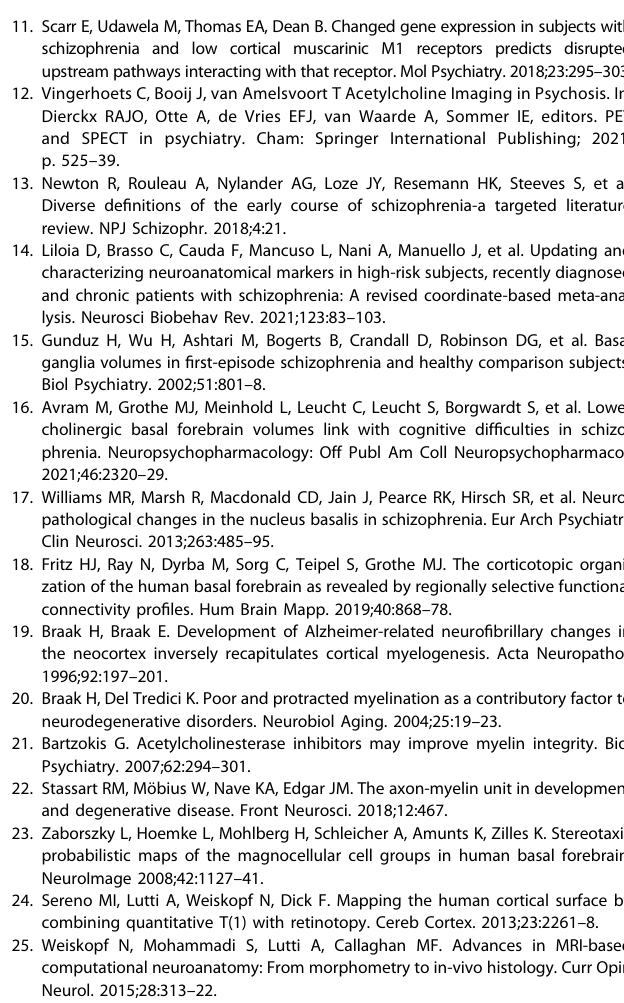
Fig. 6 Summary of neuroimaging, clinical, and transcriptomics analyses. (1) Clinical sample neuroimaging results examining case-control differences in microstructure, structure-MRS relationships, and clinical correlates of microstructure. We found increased qT1 and AxD in FEP compared to healthy controls (HC). In HC, there was a signi fi cant correlation between qT1 (left NBM) and MRS choline, while left NBM was related to negative (AxD) and manic symptom (qT1) burden. (2) Validation of basal forebrain microstructure measures using qT1 covariance between cortical and subcortical regions, and further external validation of cortical covariance by correlating with gene expression using the Allen Human Brain Atlas. Genes outlined are cholinergic receptor genes most positively associated with BF covariance for Ch1-3 and NBM, surviving FDR